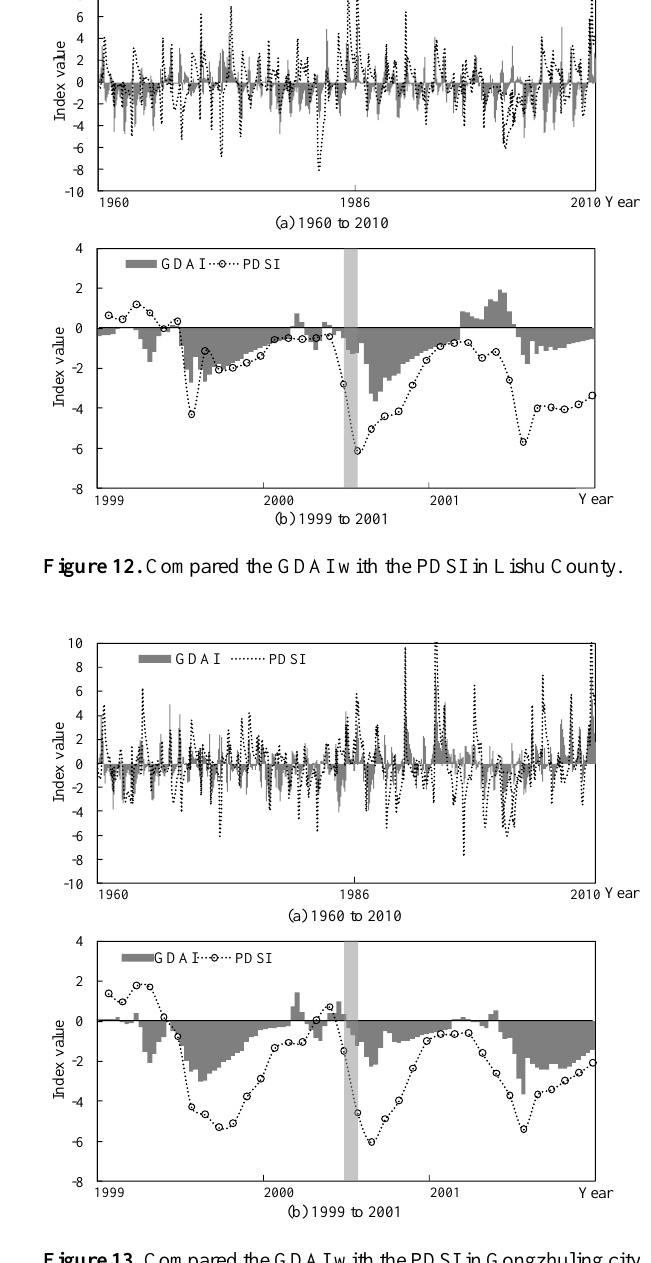
Figure 13. Compared the GDAI with the PDSI in Gongzhuling